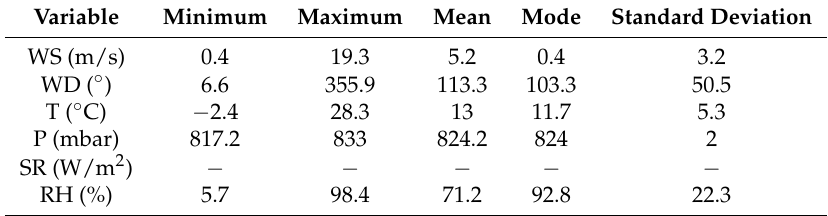
Table 2. Descriptive statistics of the involved variables of Metepec. RH, relative